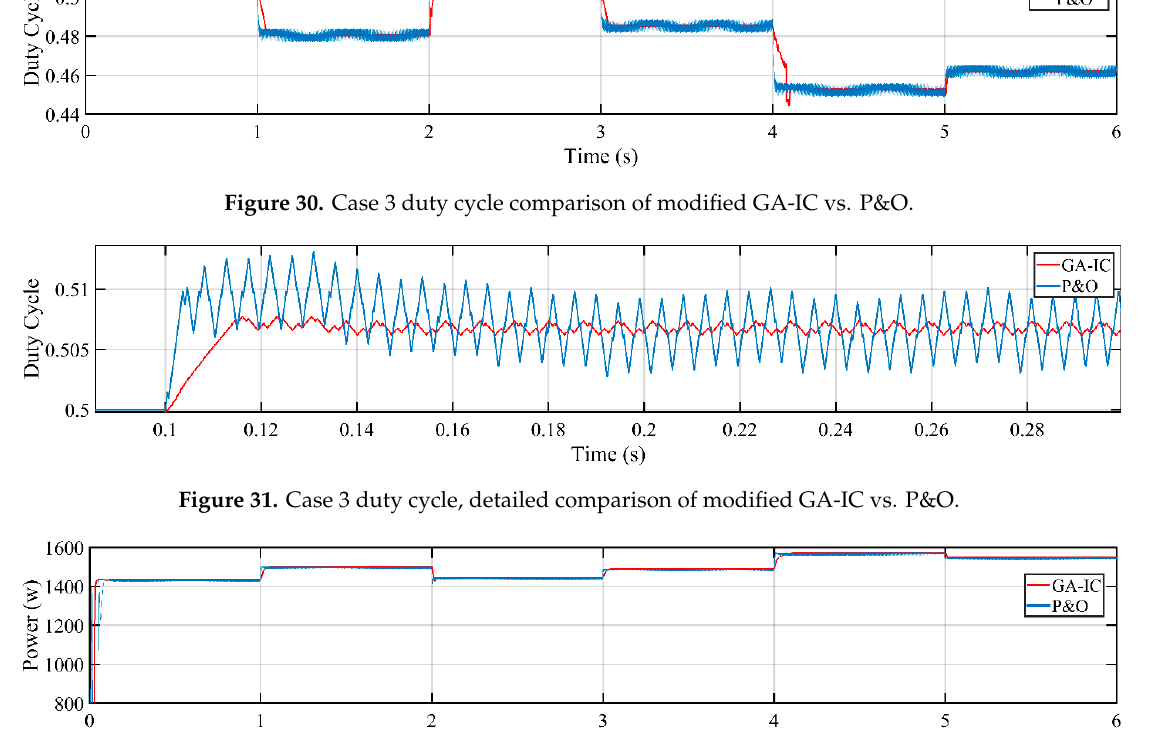
Figure 28. Case 2 current, detailed comparison of modified GA-IC vs. P&O.